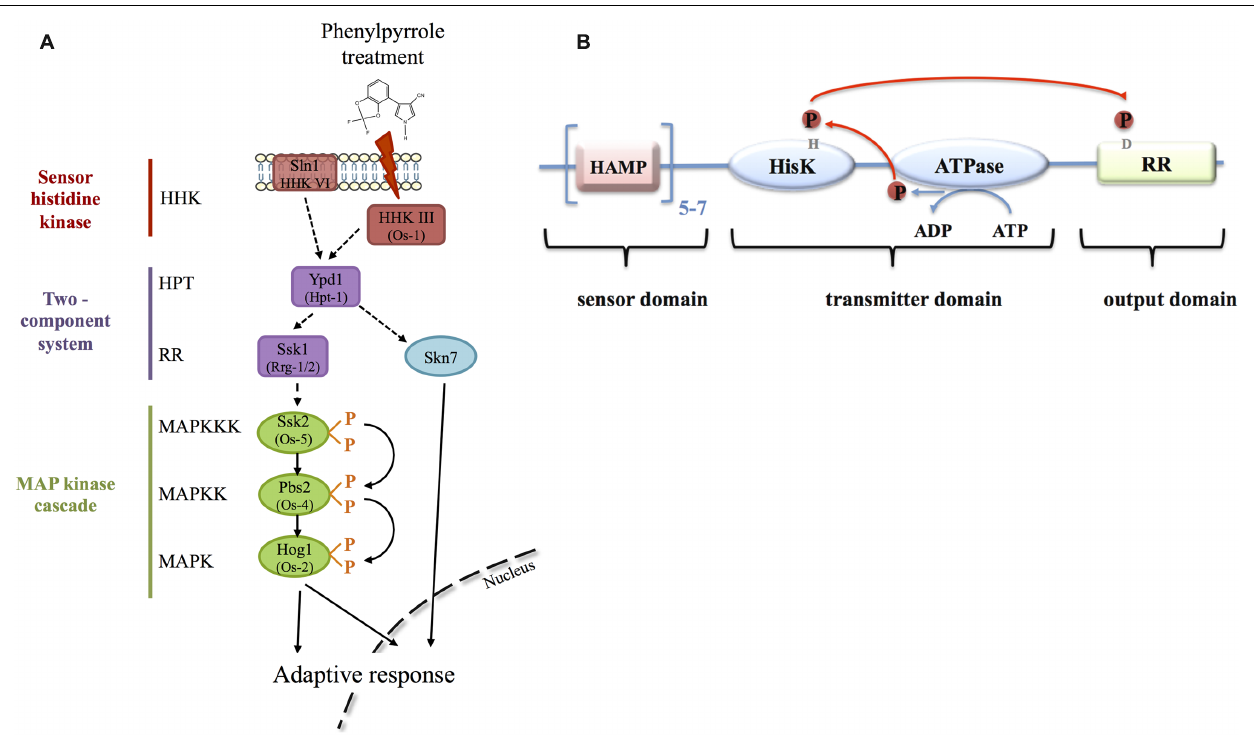
FIGURE 2 | Signal transduction of phenylpyrrole perception in ascomycetes. (A) The fungicide signal is perceived by the HHK of class III, which transmits the signal to the osmotic MAPK cascade via the histidine-phosphate transfer protein (HPT) and the response regulator (RR). Phenylpyrrole treatment ultimately leads to MAPK-phosphorylation and activation of an adaptive response either through transcriptional activation in the nucleus or through the regulation of cytoplasmic proteins. The RR Skn7, under control of Ypd1, is also involved in the transcriptional regulation in response to phenylpyrrole treatment. The involvement of the HHK VI in the adaptation is less well documented. Protein names are those of S. cerevisiae , if different those of N. crassa are indicated in brackets. Full arrows indicate positive regulations, hashed arrows indicate either positive or negative regulations (different among fungal species), or direct interactions that remain to be demonstrated (reviewed in Bahn, 2008; Tanaka and Izumitsu, 2010; Jung et al., 2012; Herivaux et al., 2016). (B) Protein structure of class III fungal HHKs. The N-terminal domain, corresponding to the sensor domain is constituted of 5–7 tandem repeats of HAMP motifs. The C-terminal half is composed of the catalytic domains HK, ATPase and the RR. The conserved histidine residue in the HK domain is phosphorylated after hydrolysis of ATP by the ATPase. The phosphoryl group is then transferred to the conserved aspartate in the RR domain, which, ultimately, transfers the phosphoryl group to the HPT